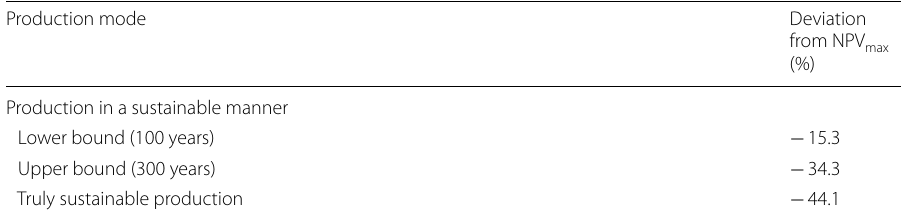
Table 5 Deviation between sustainable and profit-maximizing production modes—Case 1